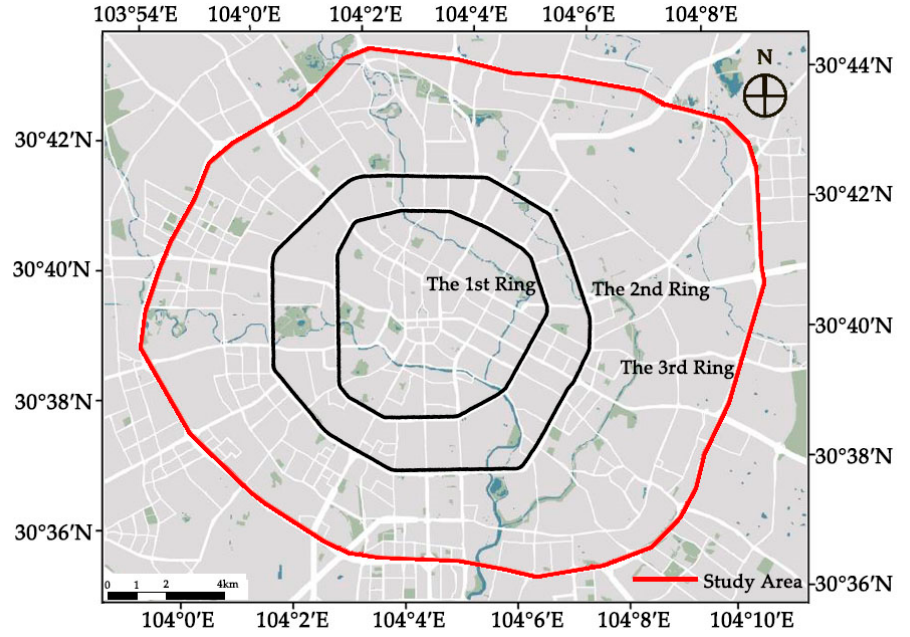
Figure 1. The study area.